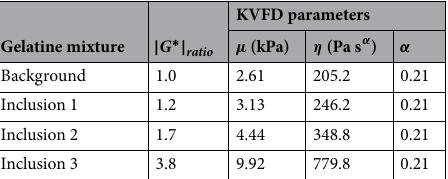
Table 4. KVFD parameters used for the wave propagation model simulations.